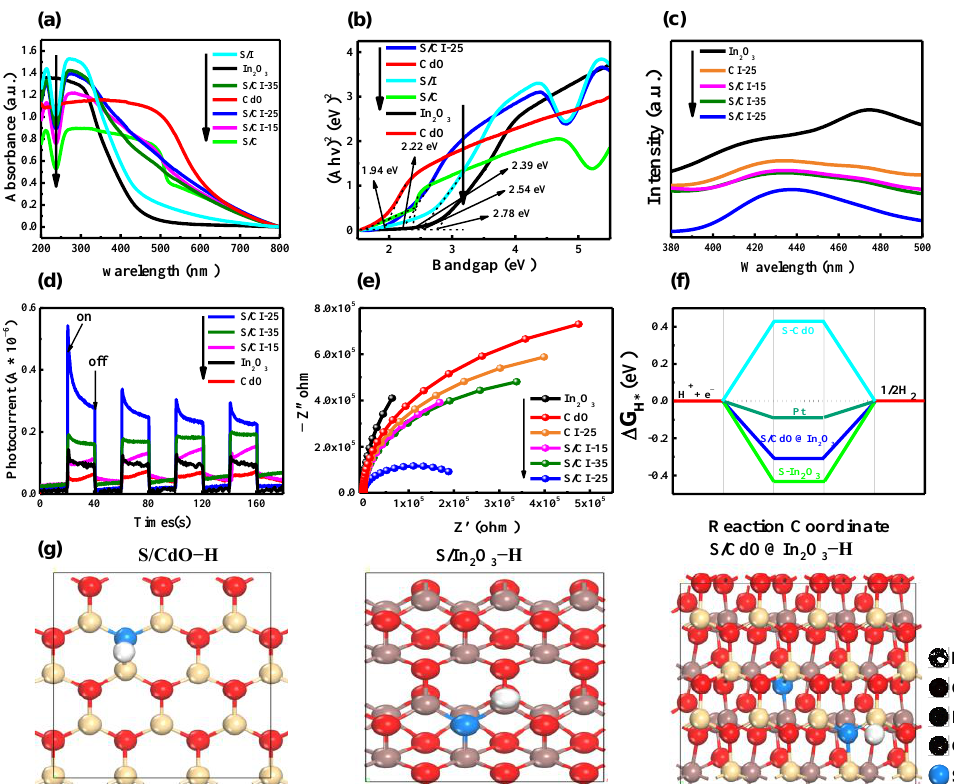
Figure 6. ( a ) UV/Vis diffuse reflectance spectra of samples, ( b ) the corresponding Tauc plots, ( c ) PL spectra, ( d ) transient photocurrent responses, ( e ) EIS spectra, ( f ) H 2 adsorption energies determined by the DFT calculations of the as-prepared samples, and ( g ) their optimized H* atom adsorbed geometrical structures.